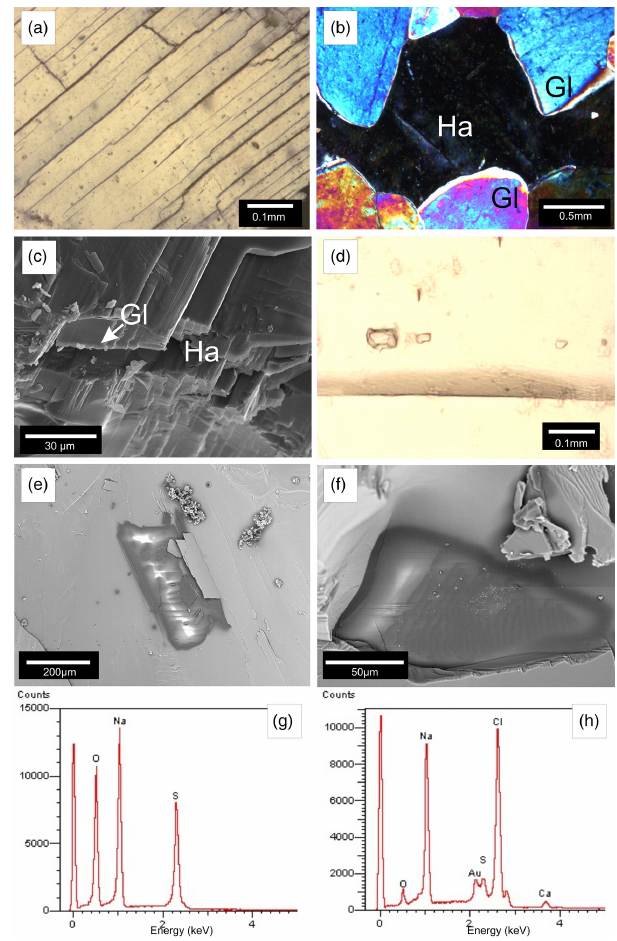
Figure 3. (a) Thenardite crystal under a thin section (crossed nicols) with a splintery fracture along cleavage planes. (b) Photomicro- graph of idiomorphic crystals of glauberite (Gl) cemented by halite (Ha) (crossed nicols). (c) SEM image of a thenardite crystal show- ing splintery fractures along cleavage planes. (d) Photomicrograph of primary fluid inclusions in a thenardite crystal mimicking the thenardite crystal termination. (e) and (f) : frozen fluid inclusion within thenardite crystals studied by Cryo-SEM SEM. (g) EDX spectrum of a fluid inclusion in a thenardite crystal with sodium and sulfate as the only ions present, analyzed by Cryo-SEM. (h) Cryo- SEM EDX spectrum of a fluid inclusion in the halite, containing sodium, chlorine and low quantities of sulfate and calcium